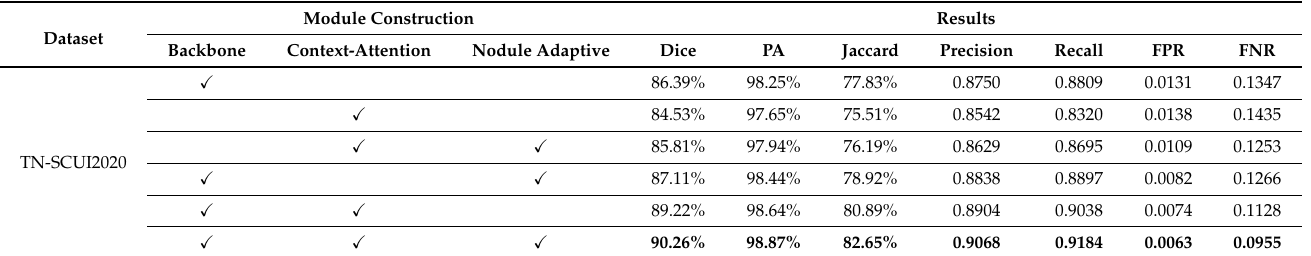
Table 3. Comparison of thyroid nodule segmentation performance using various modules combinations.